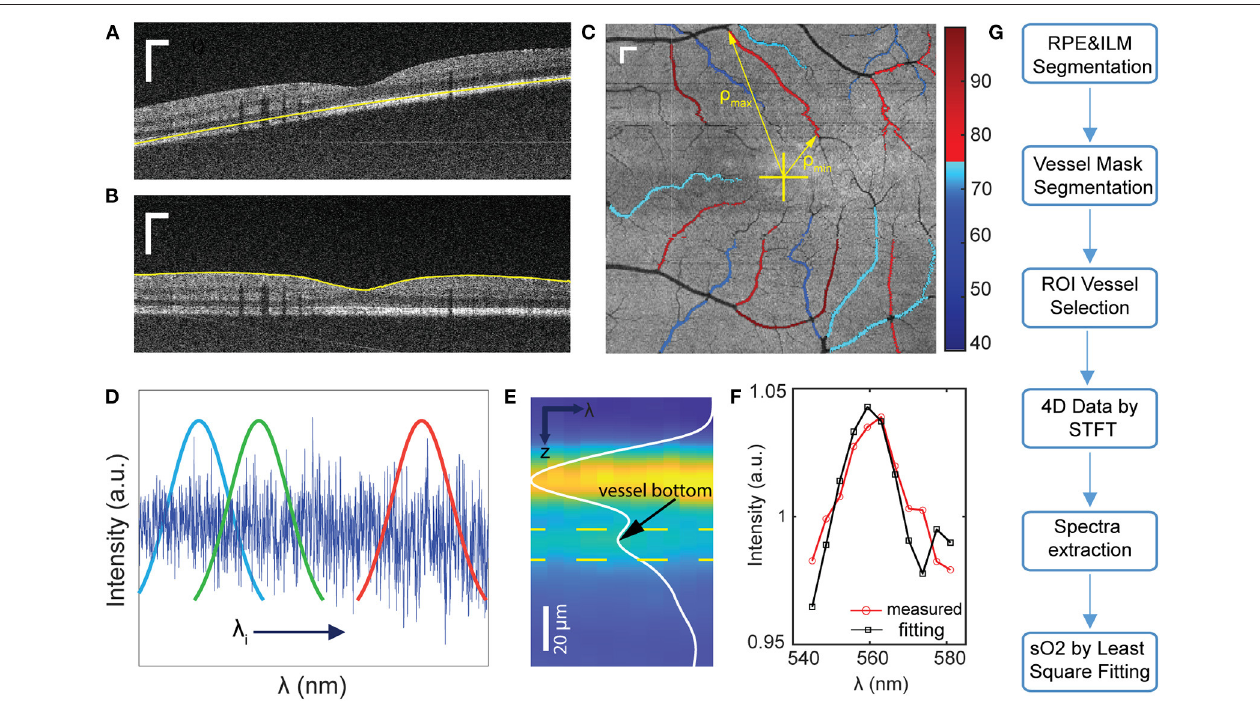
FIGURE 1 | Illustration of the data processing workflow for sO 2 calculation. (A,B) Examples of image segmentation for RPE detection, and (b) retina flattening and ILM layer detection. (C) Illustration of sO 2 mapping of parafoveal vessels. ρ min and ρ max is the minimum and maximum distance from each vessel segment to fovea. (D,E) Short time Fourier transform to extract depth-resolved spectra. Yellow dashlines indicated the depth range for spectra extraction (F) sO 2 regression by least square fitting. (G) Flow chart of data processing procedures. Scale bar: 250 µ m.